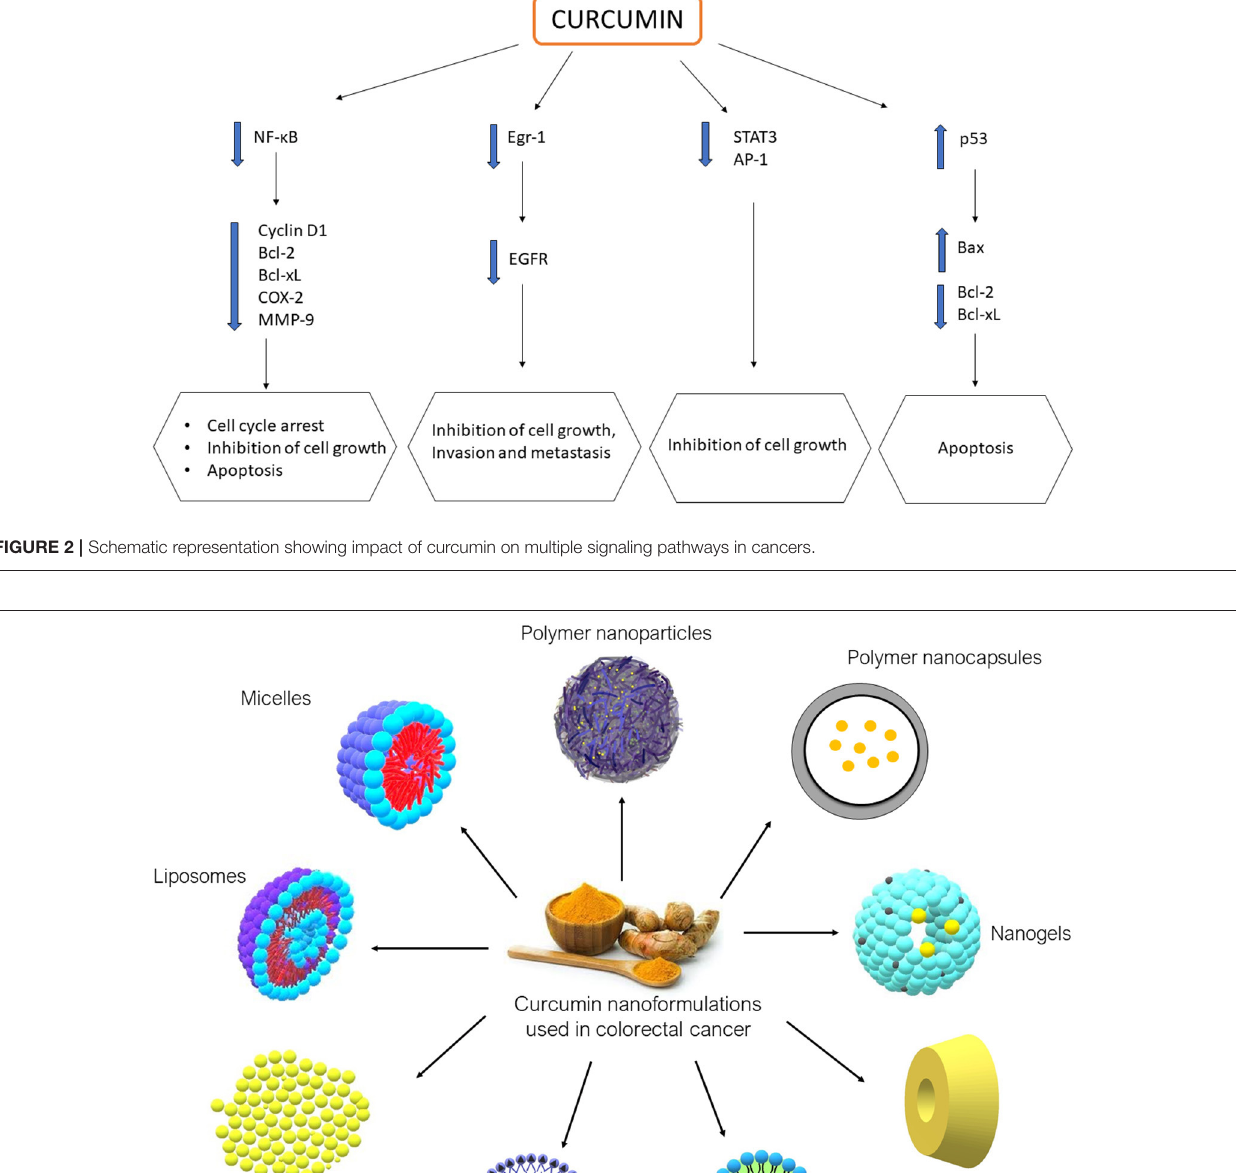
into liposomes and CaCO 3 encapsulated liposomes (LCC).